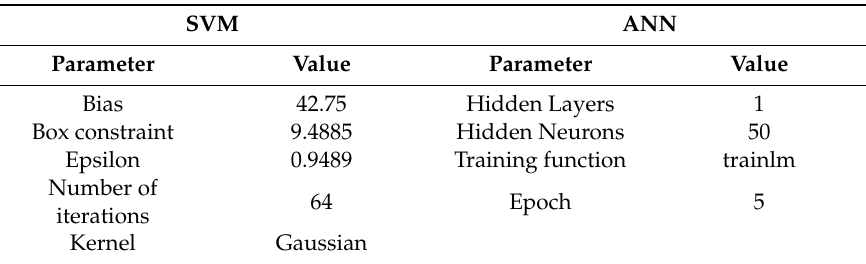
Optimum parameters of support vector machine (SVM) and ANN models with P-wave